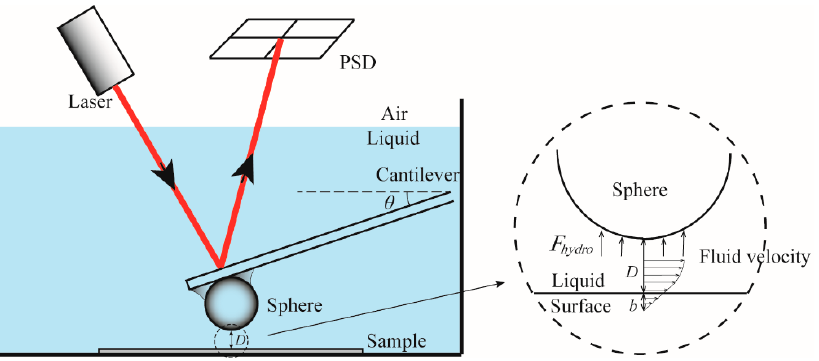
Figure 1. Schematic diagram of measurement of AFM colloidal probe in contact mode. The arrows in the cross-sectional view of the solid–liquid interface represent the size and direction of the fluid flow.